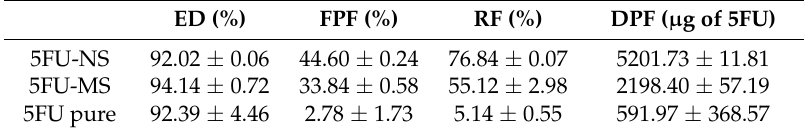
Table 1. Aerodynamic properties by